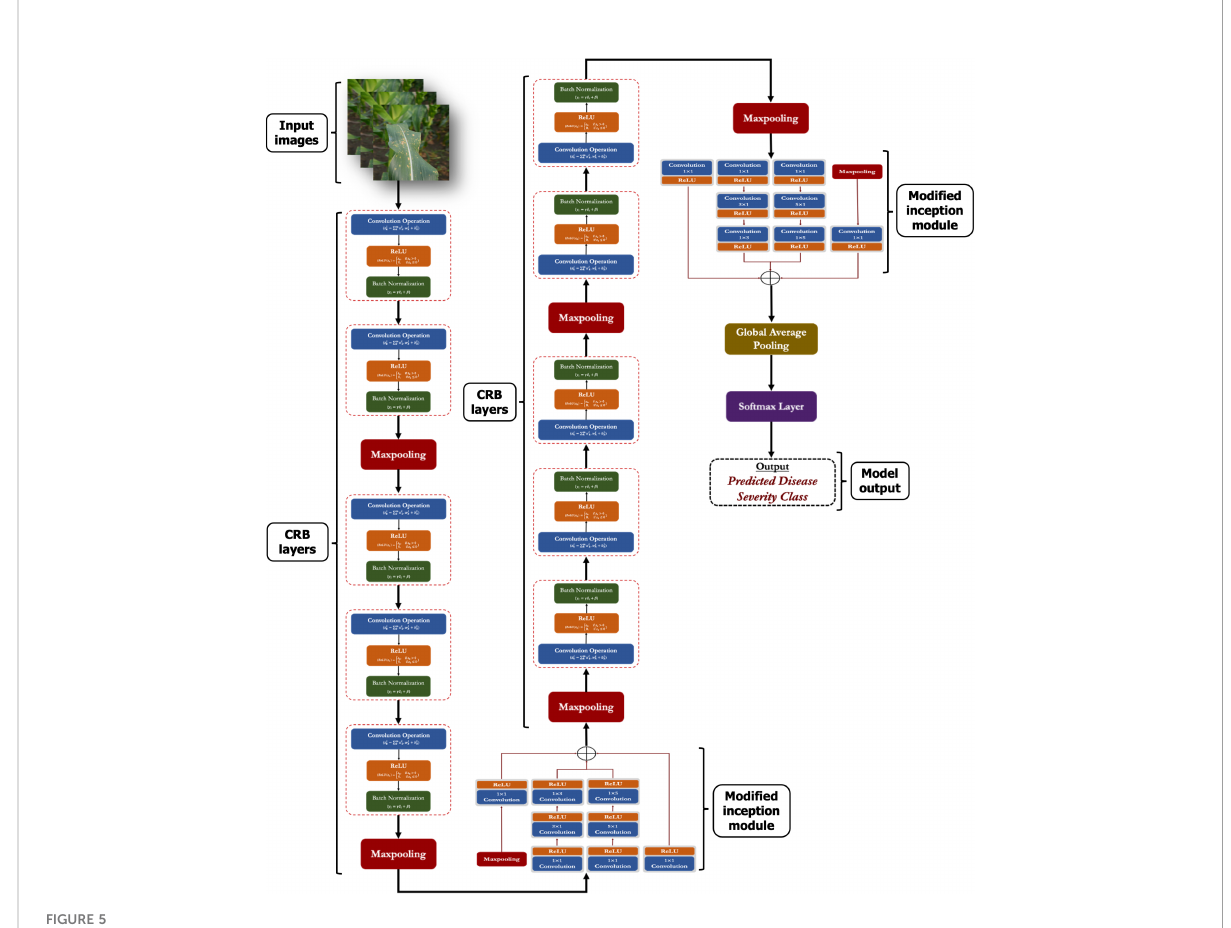
FIGURE 5 Overall architectural framework of the proposed CNN